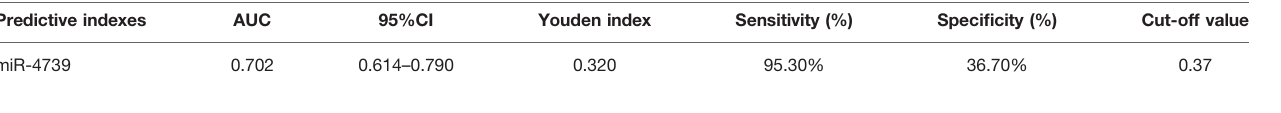
TABLE 1 | Diagnostic value of miR-4739 expression level in GC. Predictive indexes